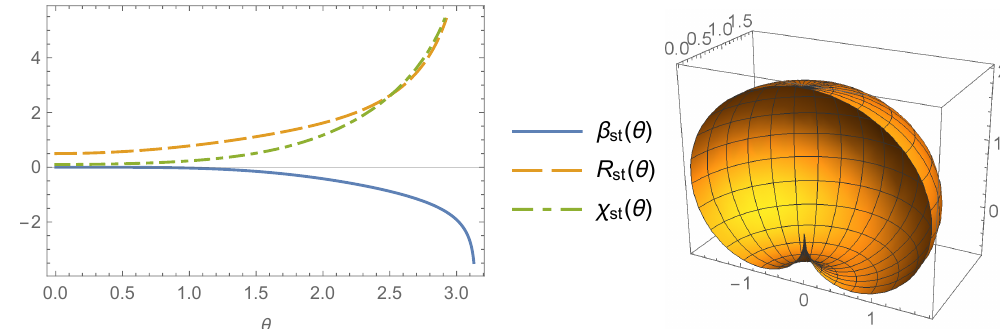
Figure 1. On the left: dependence of the stationary metric parameter β st , the Ricci scalar R st and the scalar field χ st on the extra space azimuthal angle θ . On the right: image of the shape of two-dimensional extra space defined by the metric